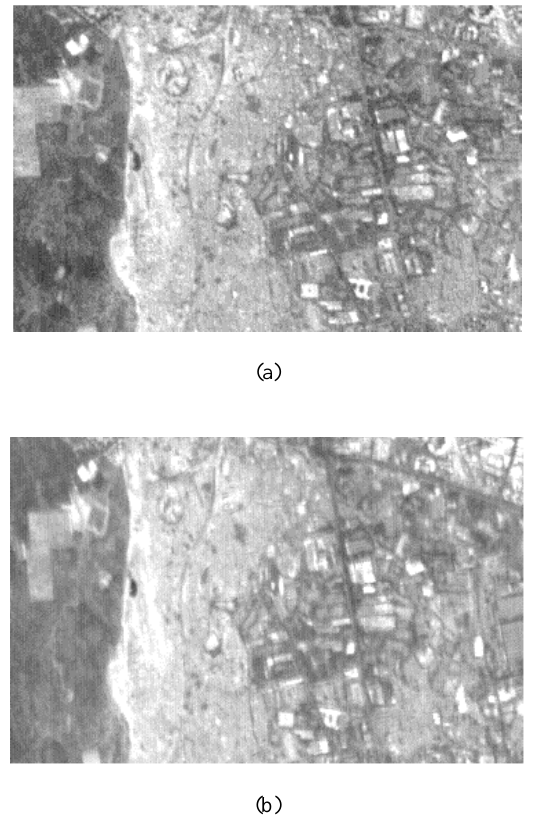
Figure 2. (a) Left Image (b) Right Image of test image pair